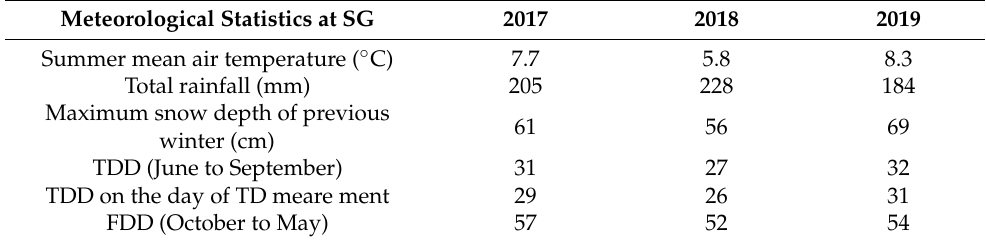
√ TDD denotes the square root